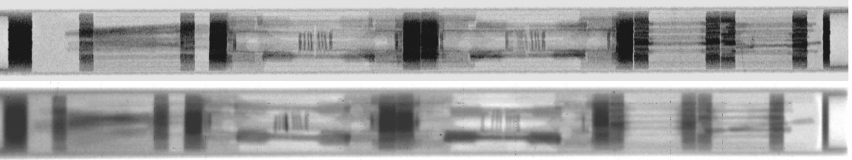
Figure 16. A test rod with steel specimens in encapsulated PbBi-eutectic before ( top ) and after ( bottom ) exposure in SINQ